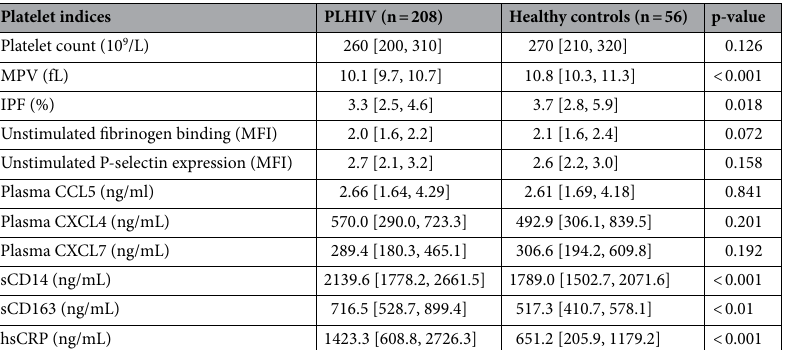
Table 2. MPV: mean platelet volume. Unstimulated platelet aggregation measured as Fibrinogen binding by flowcytometry in median fluorescence intensity (MFI). Unstimulated platelet degranulation measured as P-selectin expression by flow cytometry by MFI. Data were analyzed using Mann–Whitney U test. IPF immature platelet fraction as a percentage of platelet count (Sysmex, Kobe, Japan); sCD14 serum levels of CD14, a marker of monocyte activation; sCD163 serum levels of CD163, a monocyte- and macrophage-specific scavenger receptor; hsCRP high sensitive C-reactive